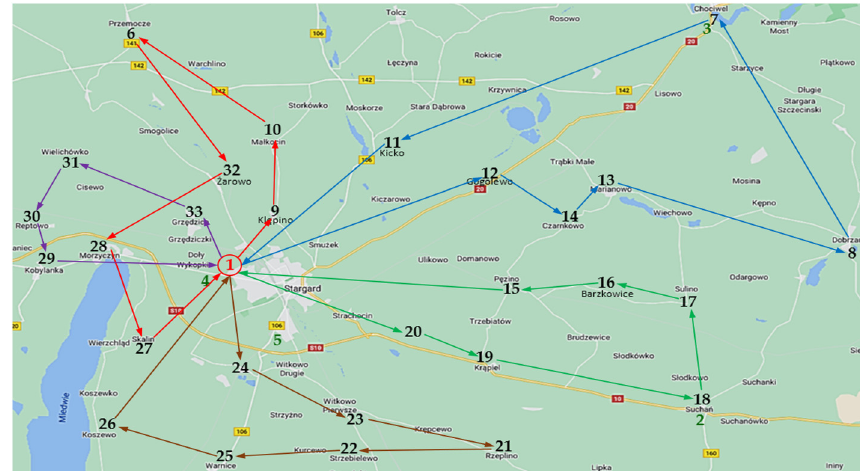
Figure 8. The visualization of the solution for problem 2 according to the third scenario.